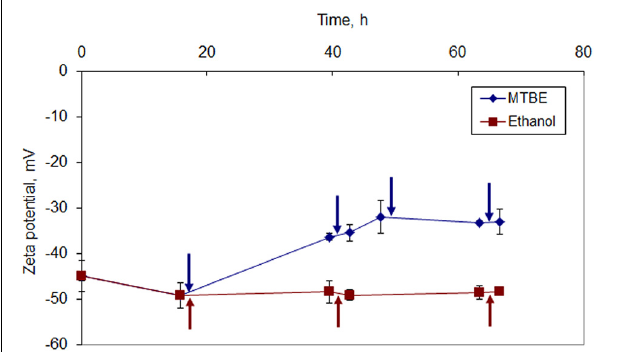
FIGURE 4 | Zeta potential of M. vaccae cells during growth in the presence of ethanol and MTBE. The first addition of solvent was done to reach an initial concentration of ethanol of 1% (v/v) and 5% (v/v) MTBE. The same respective amount was added at the times indicated by